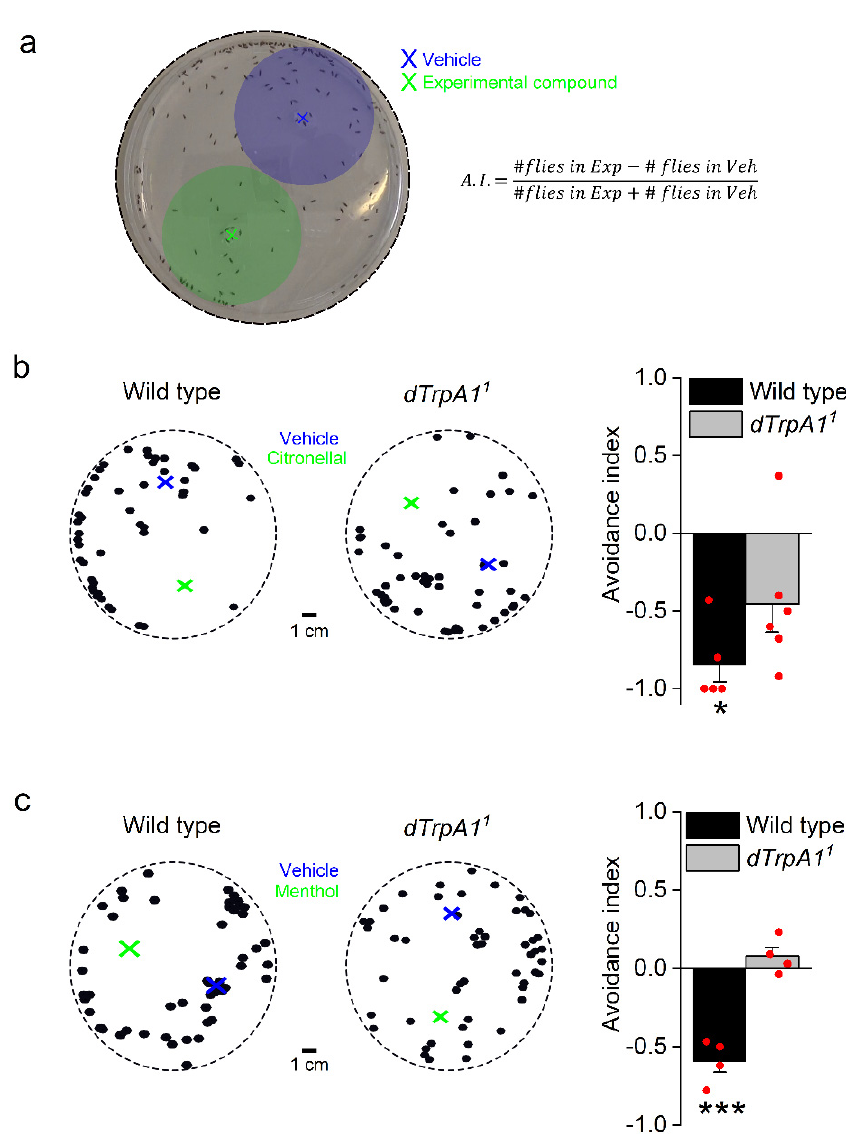
Figure 1. Adult Drosophila melanogaster flies avoid citronellal and menthol in a dTrpA1 -dependent manner. ( a ) Direct airborne repellent test. Thirty minutes after loading the vehicle and the test solutions at the locations indicated by the blue and green crosses respectively, the flies found in vehicle and test areas (marked by the blue and green shades) were counted and the avoidance index (A.I.) was calculated using the formula shown on the right. #Flies in Exp and #Flies in Veh stand for the number of flies found in the regions corresponding to the experimental compound and vehicle, respectively. Positive values of A.I. indicate preference and negative values indicate avoidance. ( b ) Examples of the positions of WT ( left ) and dTrpA1 1 ( right ) flies exposed to vehicle (blue; 20 µ L DMSO) and citronellal solutions (green; 20 µ L of 1 mM citronellal in DMSO). The bar graph on the right shows the average A.I. to citronellal for WT flies ( n = 5 plates, one-sample t -test vs. 0, p = 0.026 indicated with *) and dTrpA1 1 flies ( n = 6 plates, one-sample t -test vs. 0, p = 0.4). WT vs. dTrpA1 1 , two sample t -test, p = 0.26. ( c ) Examples of WT ( left ) and dTrpA1 1 ( right ) fly positions after exposure to vehicle (blue; 20 µ L ethanol) and the menthol solutions (green; 20 µ L of 1 mM menthol in ethanol). The bar graph on the right displays the average A.I. to menthol for WT ( n = 4 plates, one-sample t -test vs. 0, p = 0.004 indicated by ***) and dTrpA1 1 flies ( n = 4 plates, one-sample t -test vs. 0, p = 0.26). WT vs. dTrpA1 1 , two sample t -test, p =